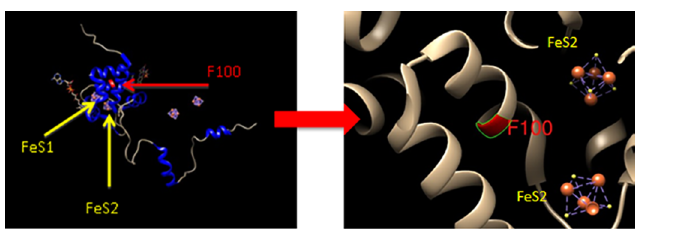
Fig 2. Location of F100L variant within the N-terminal Fe-S cluster containing the alpha helical domain I of the DPD protein. Protein modelingwas performed using UCSF Chimeraversion 1.8. The pig crystal structure (PDB ID 1gTH) was used as a template. The F100L variant could impair enzyme function by disrupting a conservedresidue F100 important for electron transfer via the [4Fe-4S]